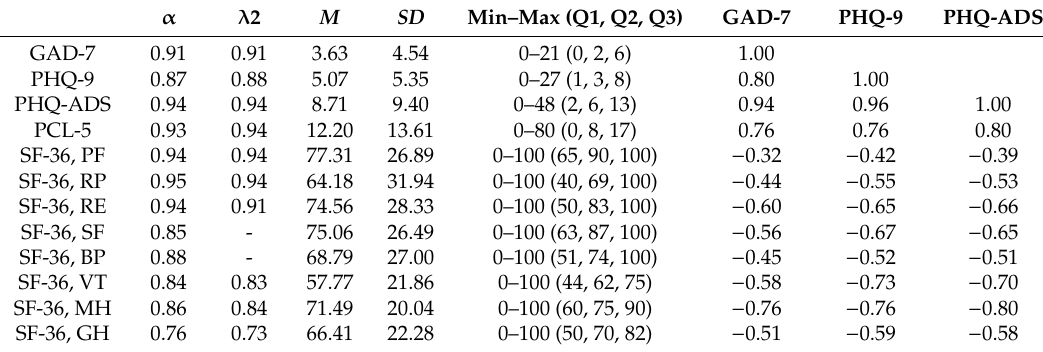
Table 2. The descriptive statistics, reliability coe ffi cients, and the correlation between variables.